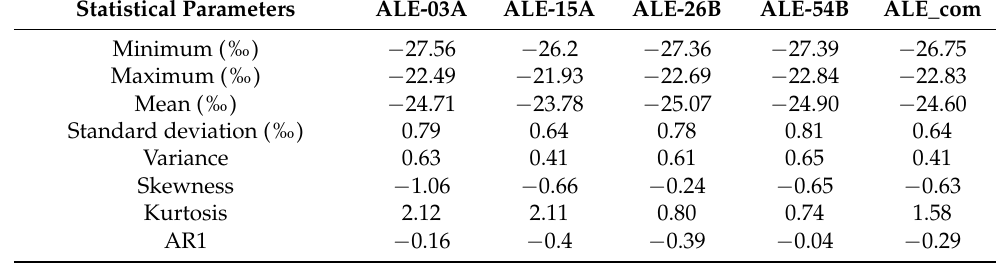
Table 3. Partial correlation analysis between the tree-ring Δ 13 C chronology in Alaer and climatic factors from April to September (1959–2018).